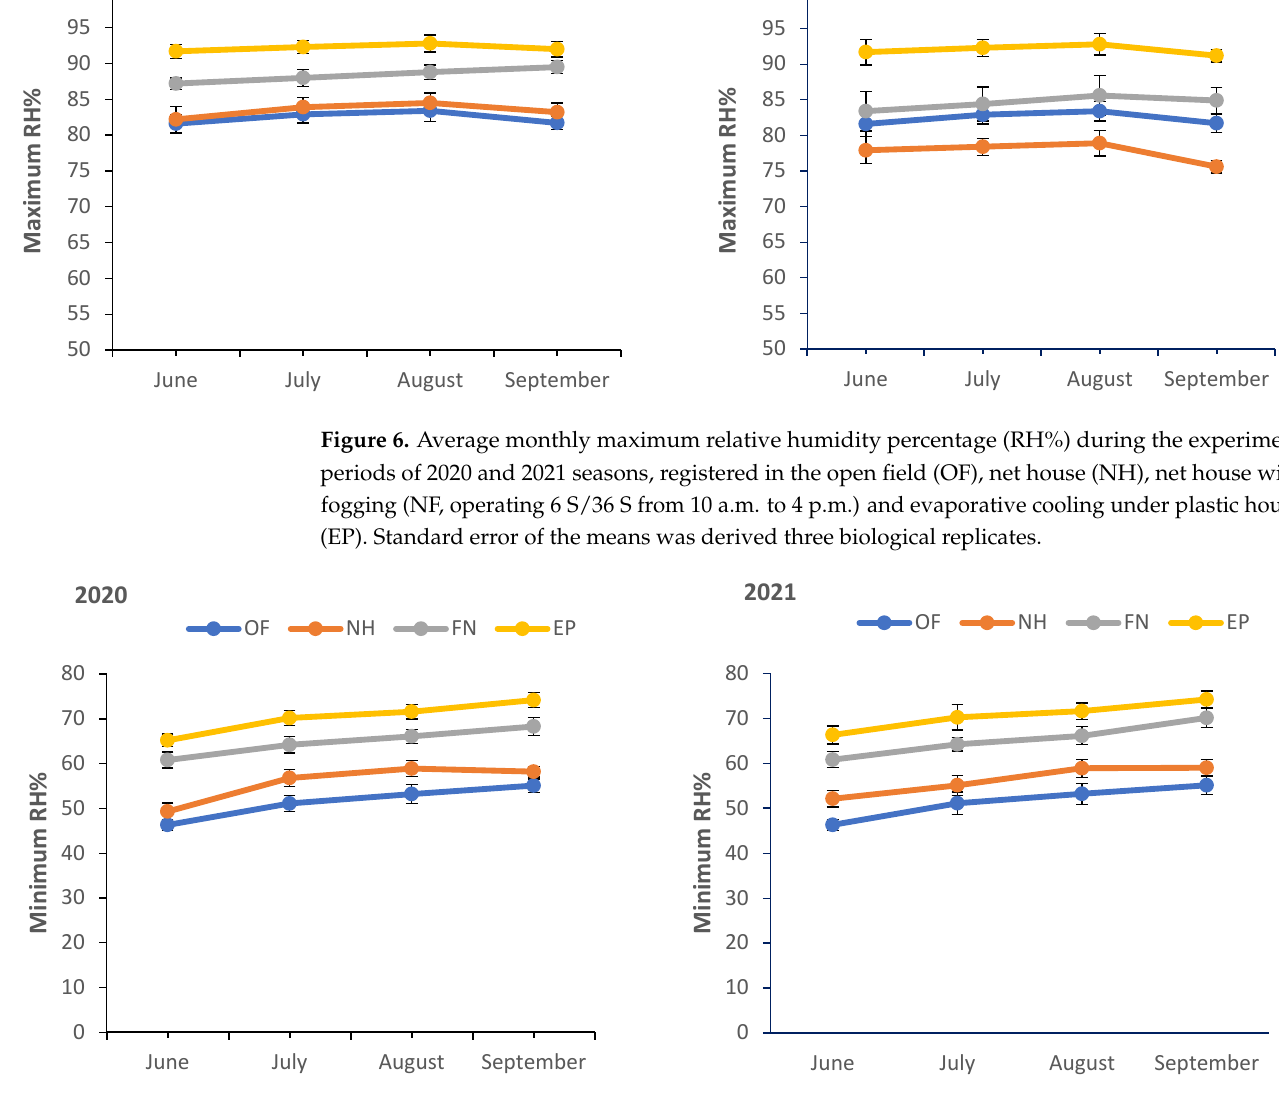
Figure 7. Average monthly minimum relative humidity percentage during the experimental periods of 2020 and 2021 seasons, registered in the open field (OF), net house (NH), net house with fogging (NF, operating 6 S/36 S from 10 a.m. to 4 p.m.) and evaporative cooling under plastic house (EP). Standard error of the means was derived from three biological